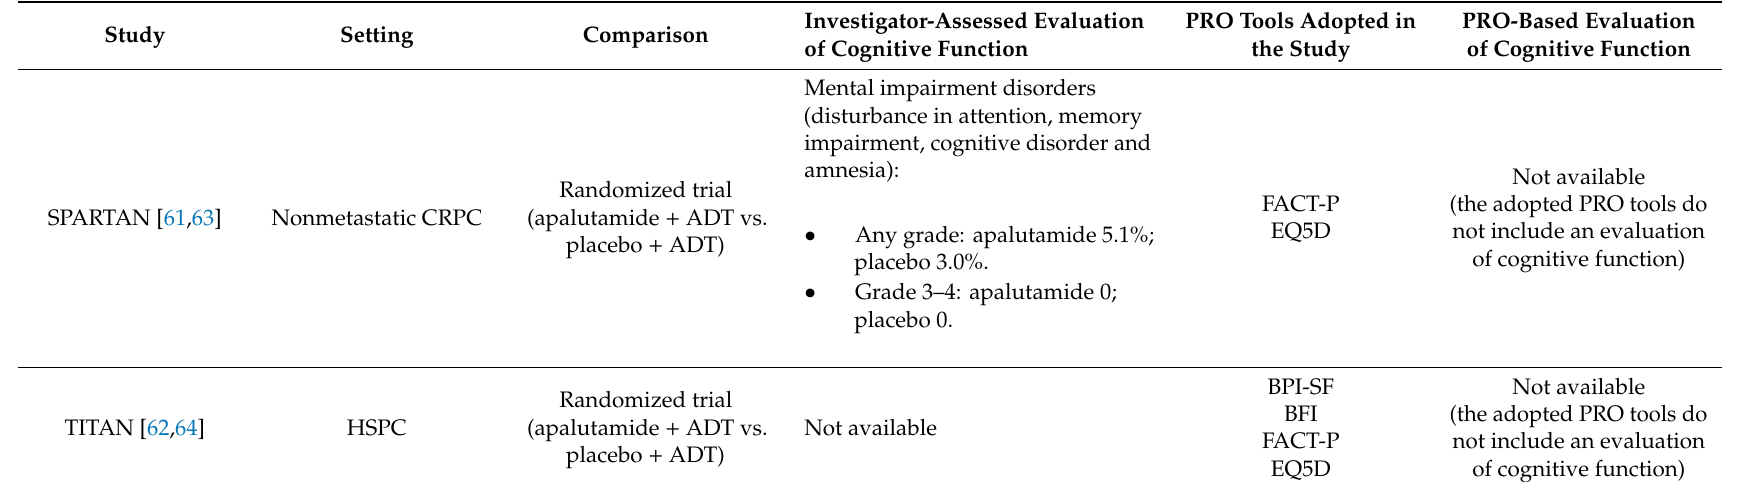
Table 4. Trials testing